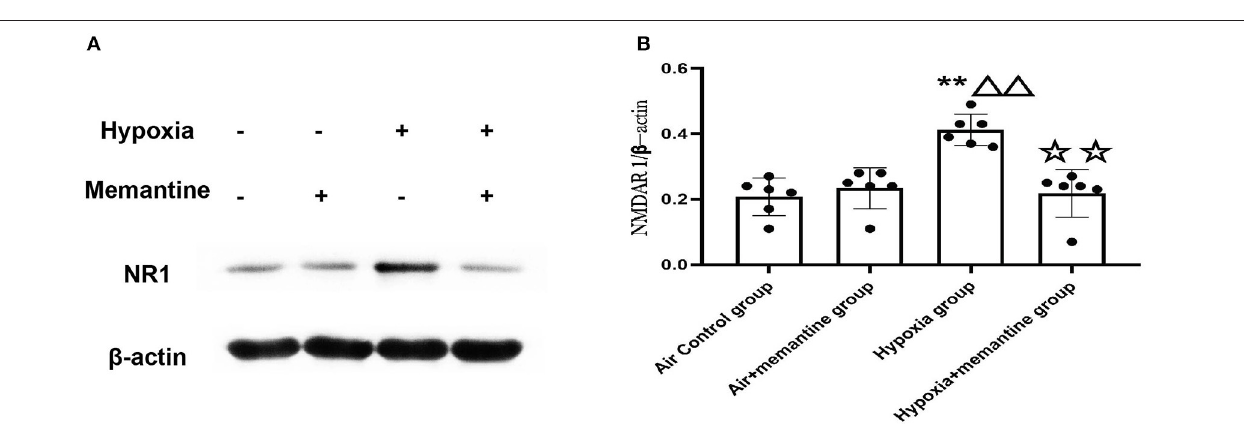
FIGURE 2 | Antenatal memantine treatment reduced the intrauterine hypoxia elevated NR1 protein expression in newborn rat heart. The representative western blot images of NR1 (A) and semi-quantified level of NR1 (B) . Compared with the air control group: * P < 0.05, ** P < 0.01; compared with the air+memantine group: △ P <0.05, △△ P < 0.01; compared with the hypoxia group: P P < 0.05, PP P < 0.01. All data are presented as a mean ± S.E.M. N = 6. All blot images are